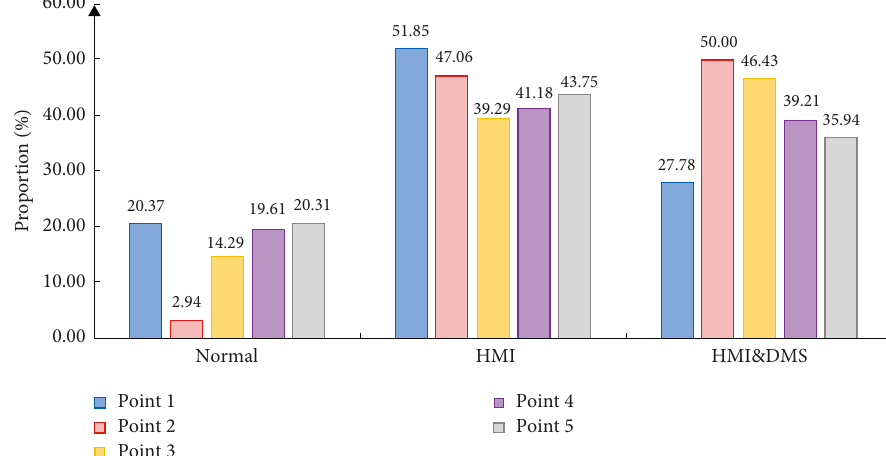
Figure 8: Deceleration ratio of warning